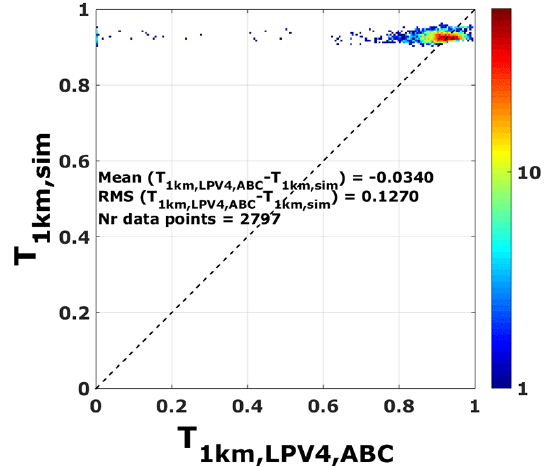
Figure 10. Modeled transmittance for 1km slant range compared with absorption- and broadband-corrected transmittance as in case of Sect. 3.1 measured by LPV4 transmissometer. Color distribution displays the number of data points per grid point (logarithmic color